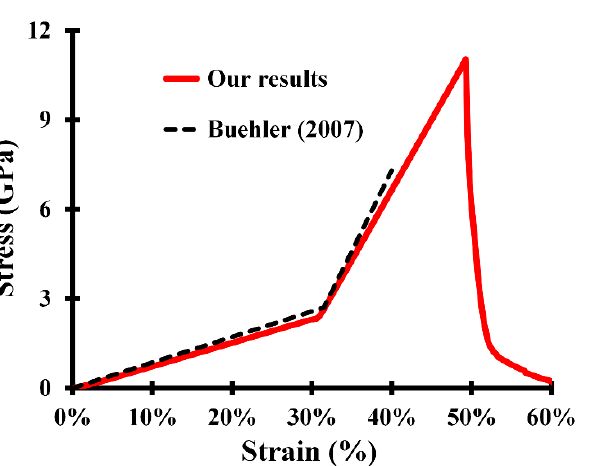
Figure 3. Current computed stress – strain variation in the single TC molecule along with Buehler et al. [42] model prediction. et al. [42] model